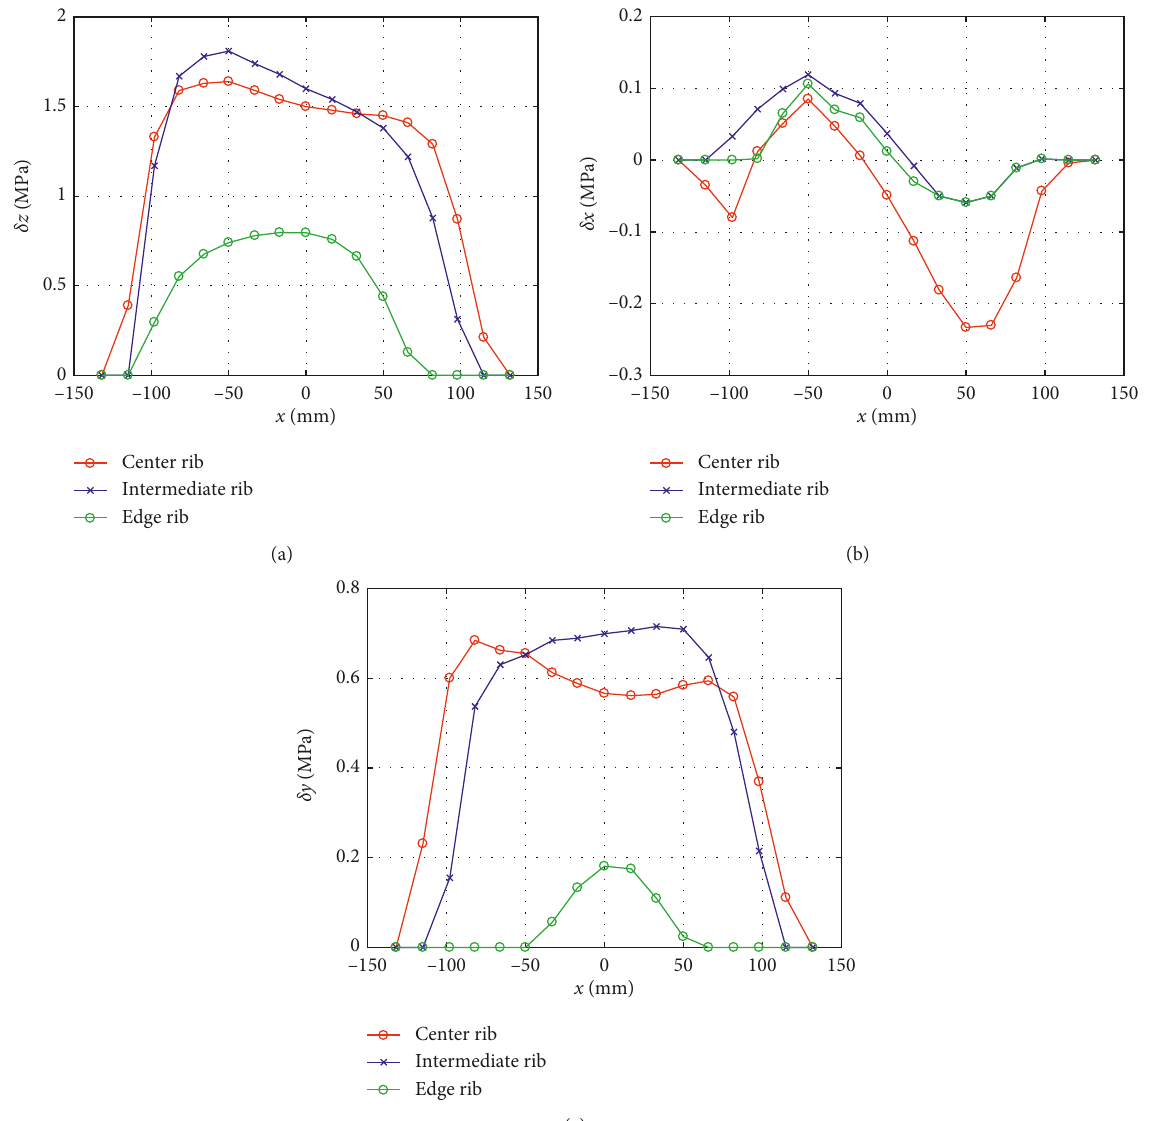
Figure 6: Comparison of contact stresses in (a) vertical, (b) longitudinal, and (c) transverse directions at cornering